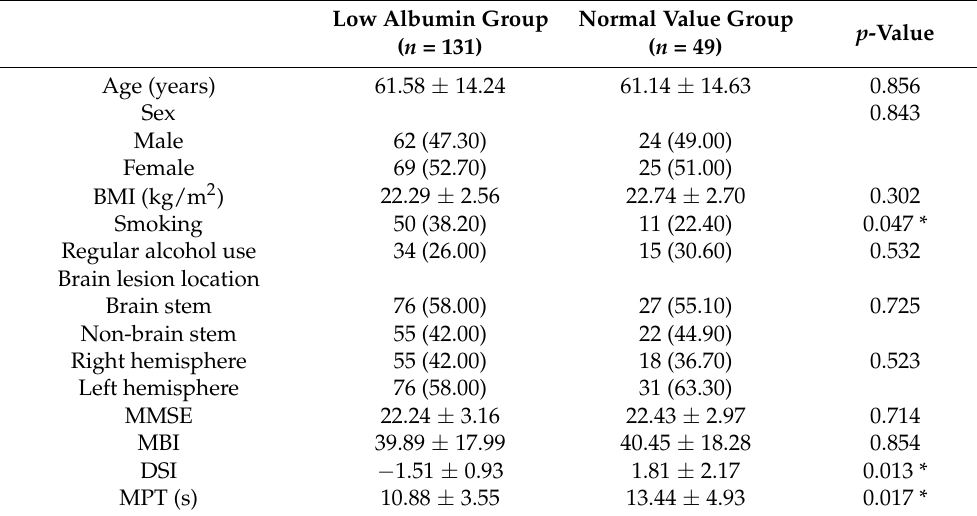
Table 3. Comparison of characteristics between the low albumin group and the normal value